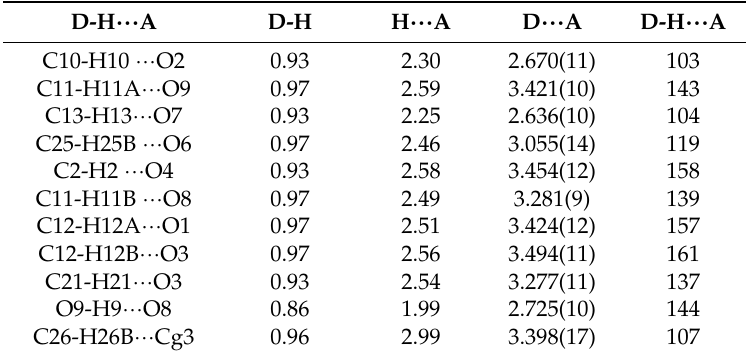
Table 3. Hydrogen bonding and C-H ··· π stacking interactions (Å, ◦ ) for complex 1